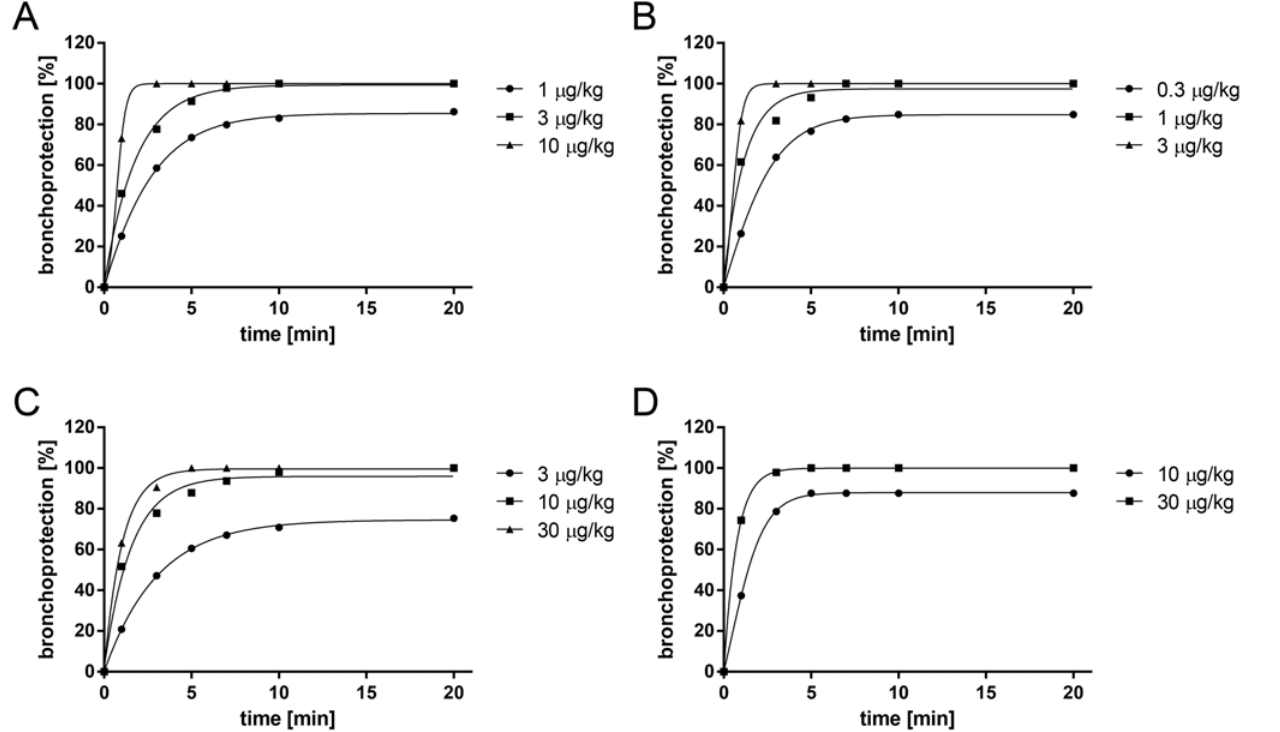
Fig 1. Time to onset of action of β 2 -agonists in the acetylcholine-induced bronchoconstriction model in guinea